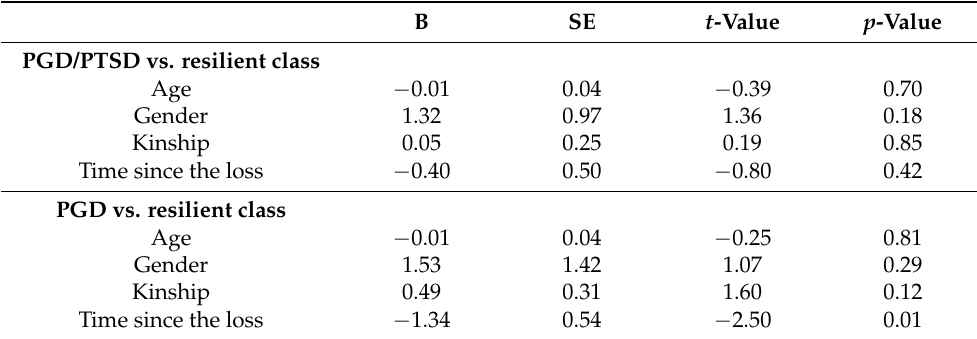
Table 4. Latent class model with analysis of